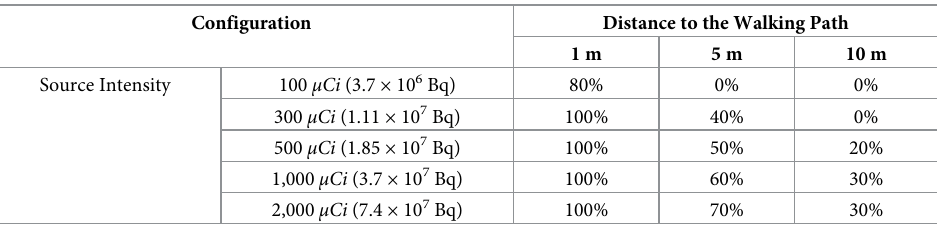
Table 3. Source identification accuracy with 5 meters distance